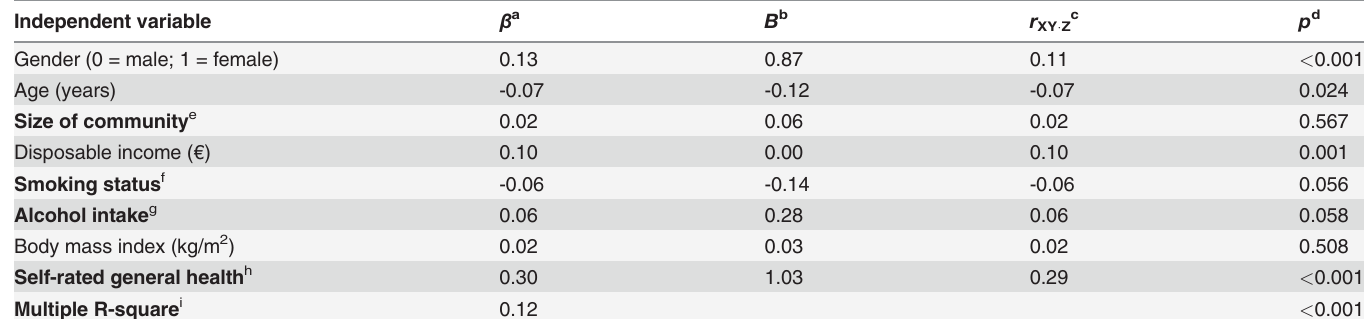
Table 2. Relationship between socio-demographic variables, lifestyle characteristics and self-rated general health and life satisfaction.